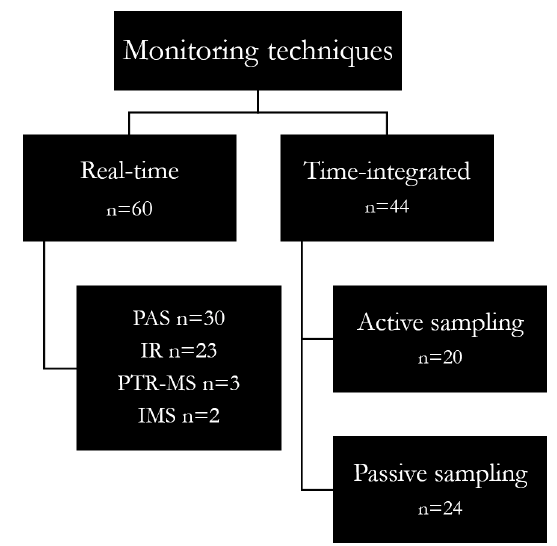
Figure 6. Block Diagram of monitoring approaches for anaesthetic gases. PAS = photoacoustic spectroscopy; IR = infrared spectrophotometry; PTR-MS = proton-transfer-reaction mass spectrometry; IMS = ion mobility spectrometer.